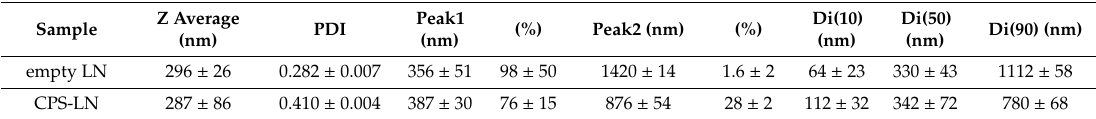
Particle size, intensity distribution (Di), and polydispersity index (PDI) of LN based